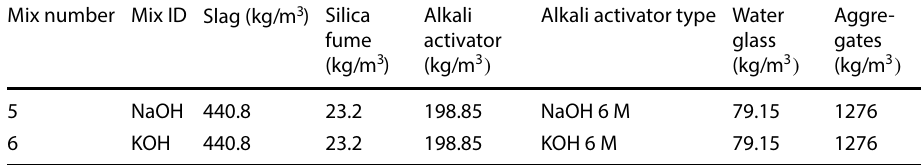
Table 7 Mix proportion of geopolymer-based